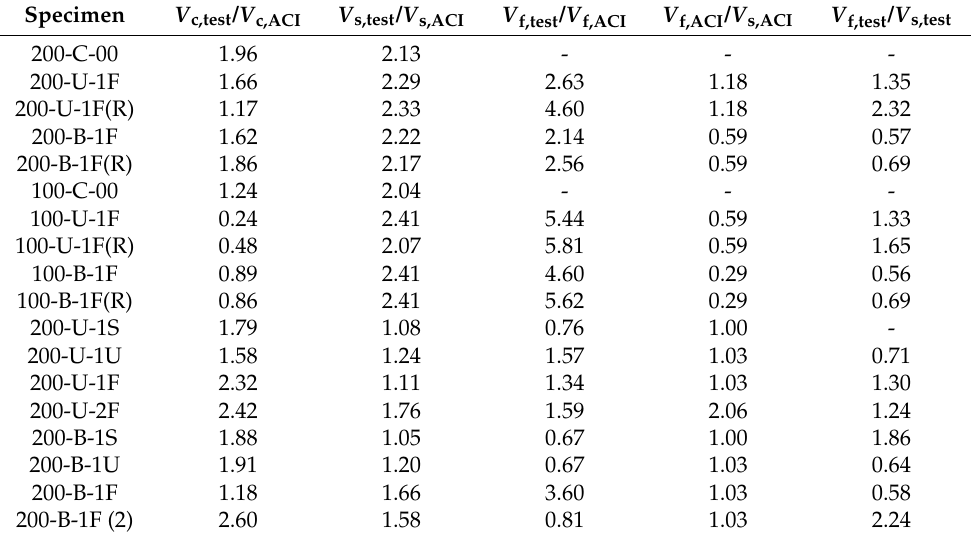
Table 4. Shear contribution of each